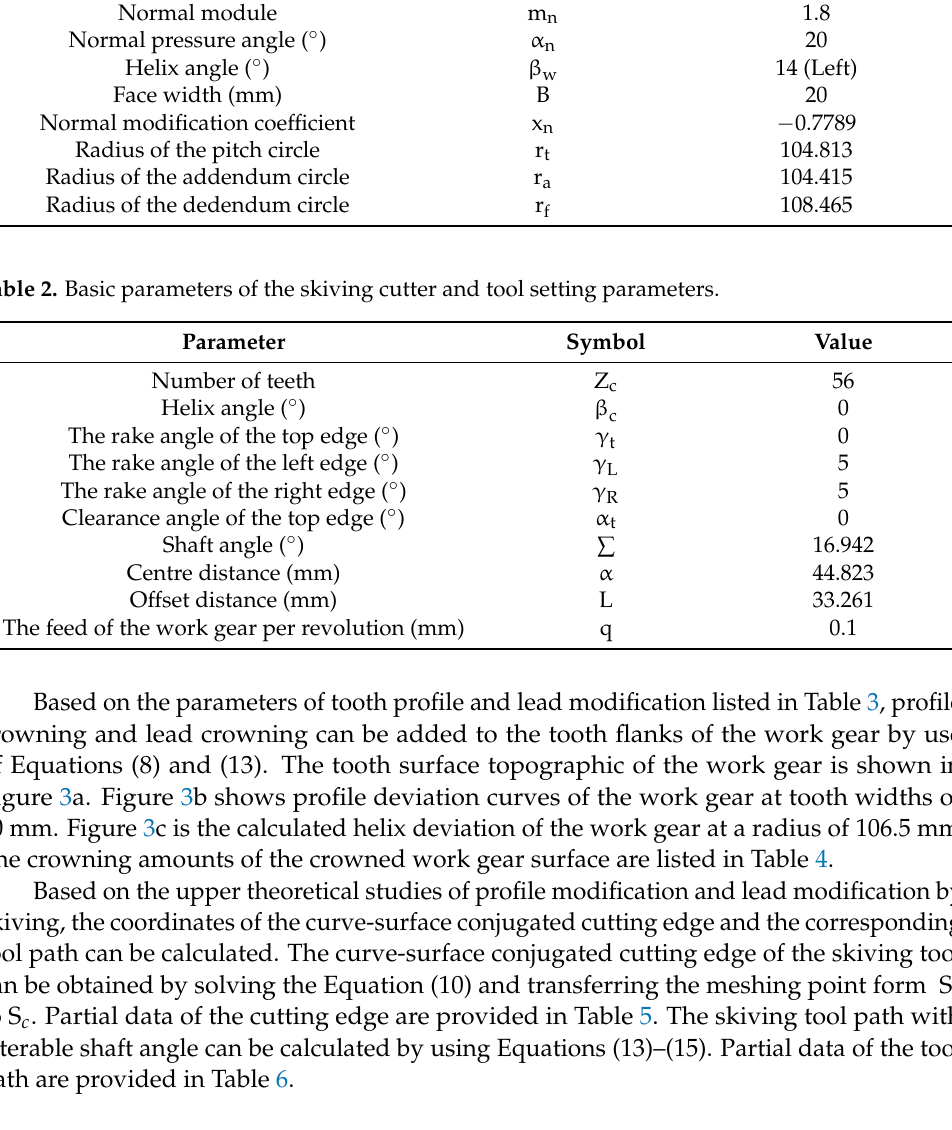
Table 3. Parameters of tooth profile and lead